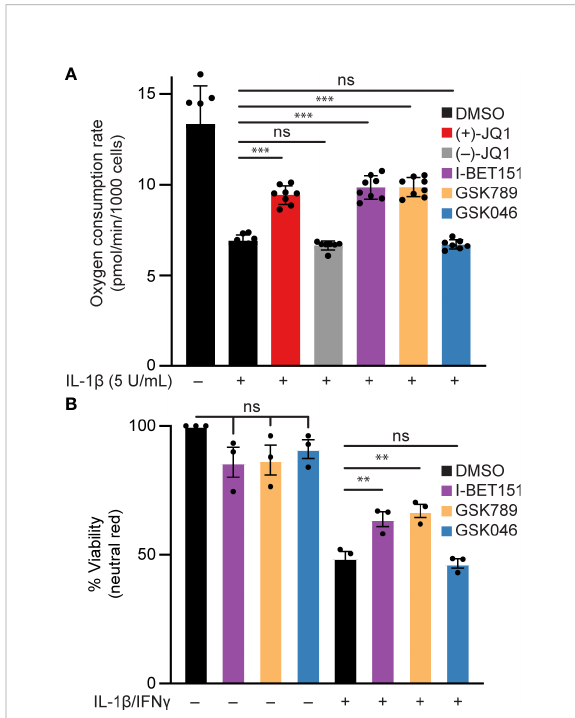
FIGURE 6 BET bromodomain inhibition prevents IL-1 b -induced loss of function in b -cells. (A) Basal oxidative consumption rate (OCR) was measured in INS 832/13 cells following 1-hour pretreatment with 0.5 m M (+)-JQ1, 0.5 m M ( – )-JQ1, 1 m M I-BET151, 1 m M GSK789, 1 m M GSK046, or DMSO followed by 24-hour treatment with 5 U/mL IL-1 b . The mean OCR of 5-6 replicates was plotted with error bars representing SD. (B) Neutral red analysis for cell viability in INS 832/13 cells treated for 1 hour with 1 m M indicated BET bromodomain inhibitor followed by IL-1 b (5 U/mL) and IFN- g (150 U/mL) for 24 hours. The mean cell viability was plotted for three independent biological replicates with error bars representing SEM. Signi fi cance was determined by ANOVA followed by Dunnett ’ s multiple comparisons test, *< 0.05, **< 0.01, ***< 0.005, and ns >